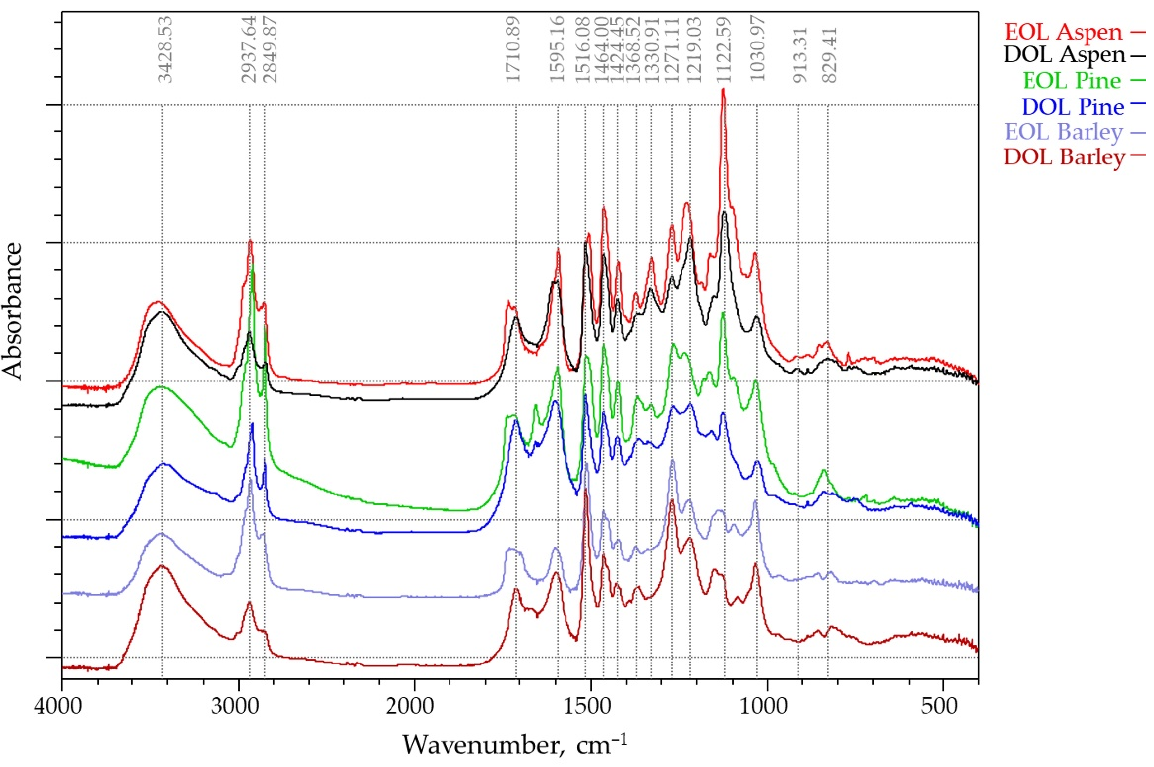
Figure 3. FT-IR spectra of EOL and DOL lignins that were isolated from three different biomass feedstocks (aspen, pine, and barley straw).